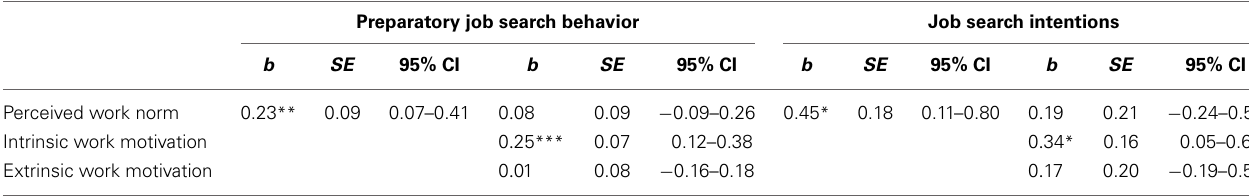
Table 2 | Motivation mediates the relation between perceived own group’s work norm and job searching.